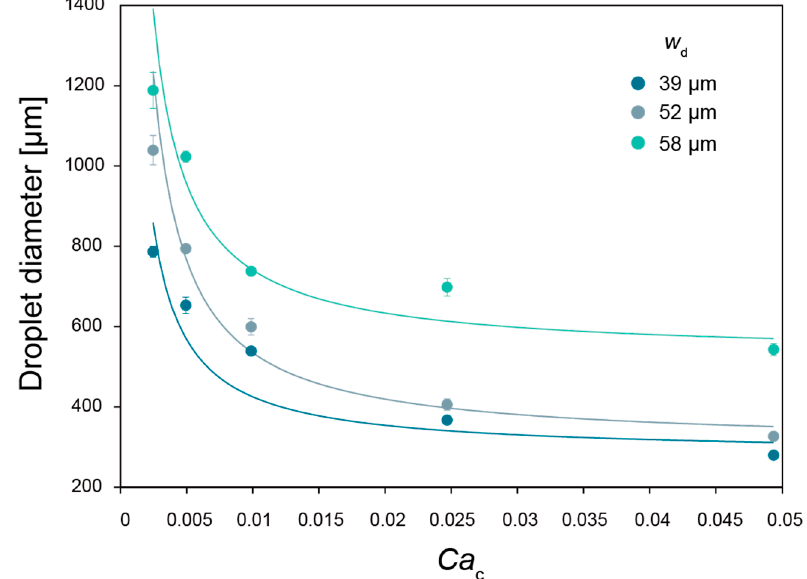
Figure 4. Droplet diameter versus capillary number of the outer fluid for gelatin in corn oil emulsion using the co-flow microfluidic device. Solid curve was a fit using Equation (1), where w d = 39 μ m, a = 7.3, b = 0.1; w d = 52 μ m, a = 5.9, b = 0.1; w d = 58 μ m, a = 9.1, b = 0.1). Ca c is computed using the following fluid properties: η c = 0.075 Pa s, γ = 0.02 N/m, and w c = 1.3 mm. Error bars represent standard deviation; sample size n > 19.